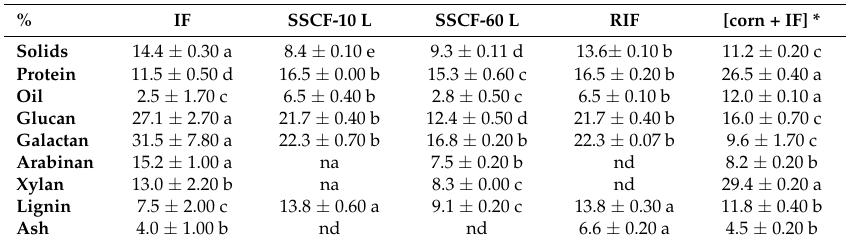
Table 2. Composition of starting material and residual materials after enzymatic treatment and co-fermentation with S. cerevisiae and E. coli KO11.